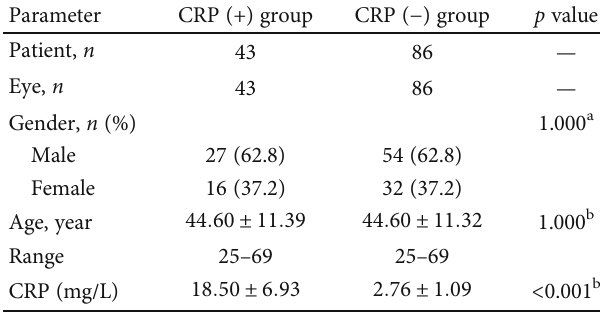
Table 1: Demographic characteristics.